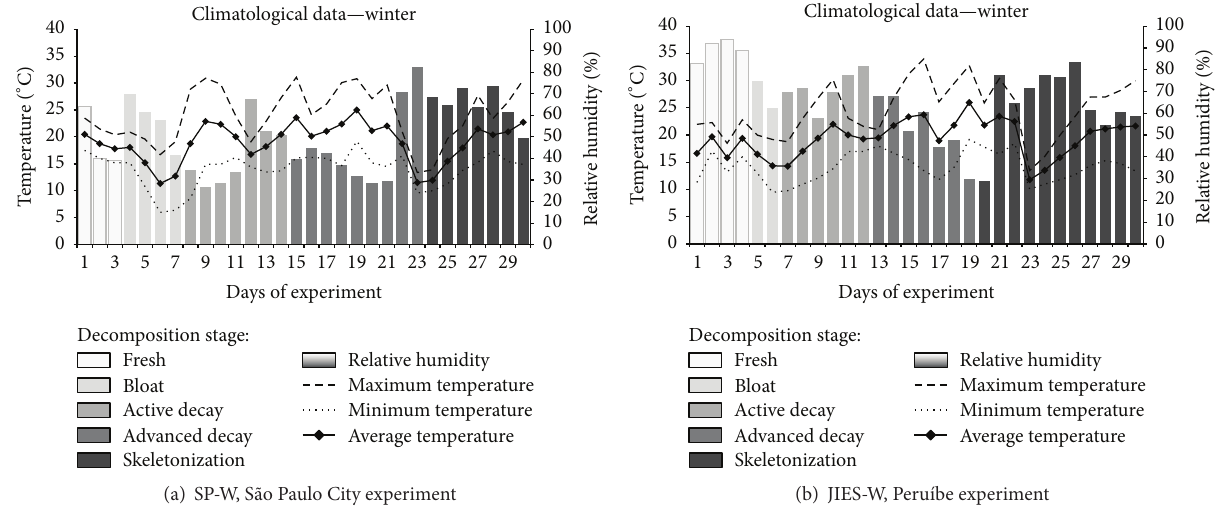
Figure 2: Climatological data for the winter